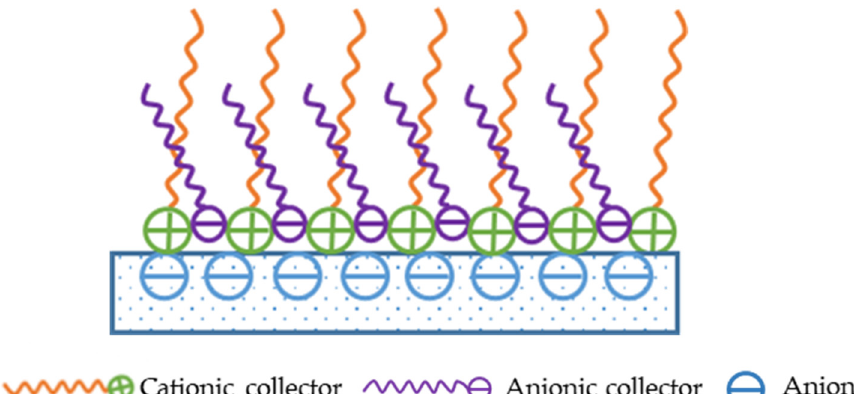
Figure 8. Co-adsorption of cationic and anionic collectors at the quartz surface.